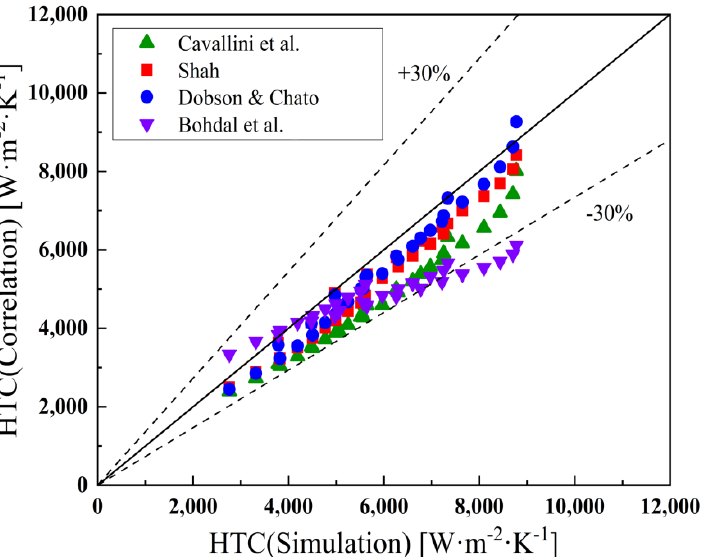
Figure 3. Comparison of calculated results of heat transfer coefficient from empirical correlations with simulated results. Cavallini et al. [38], Shah [39], Dobson and Chato [40], and Bohdal et al. [41]. The predicted HTC by Cavallini et al. [38], Shah [39], and Dobson and Chato [40] are smaller than that in the simulation, especially operating at low mass fluxes. Bohdal et al. [41] predicts a larger value than the simulated results at low mass flux, while the predicted value gets smaller than the simulated value at high mass flux. Note that the predicted value of Bohdal et al. [41] correlations display a small range, showing insensitive features to mass flux and vapor quality under the current working conditions. A comprehensive comparison shows that the correlation proposed by Dobson and Chato [40] shows the highest accuracy in comparison to the simulated results in this paper. The mean absolute deviation (MAD) and mean relative deviation (MRD) values are calculated using Equations (21) and (22) to evaluate the reliability of correlational predic- tions.